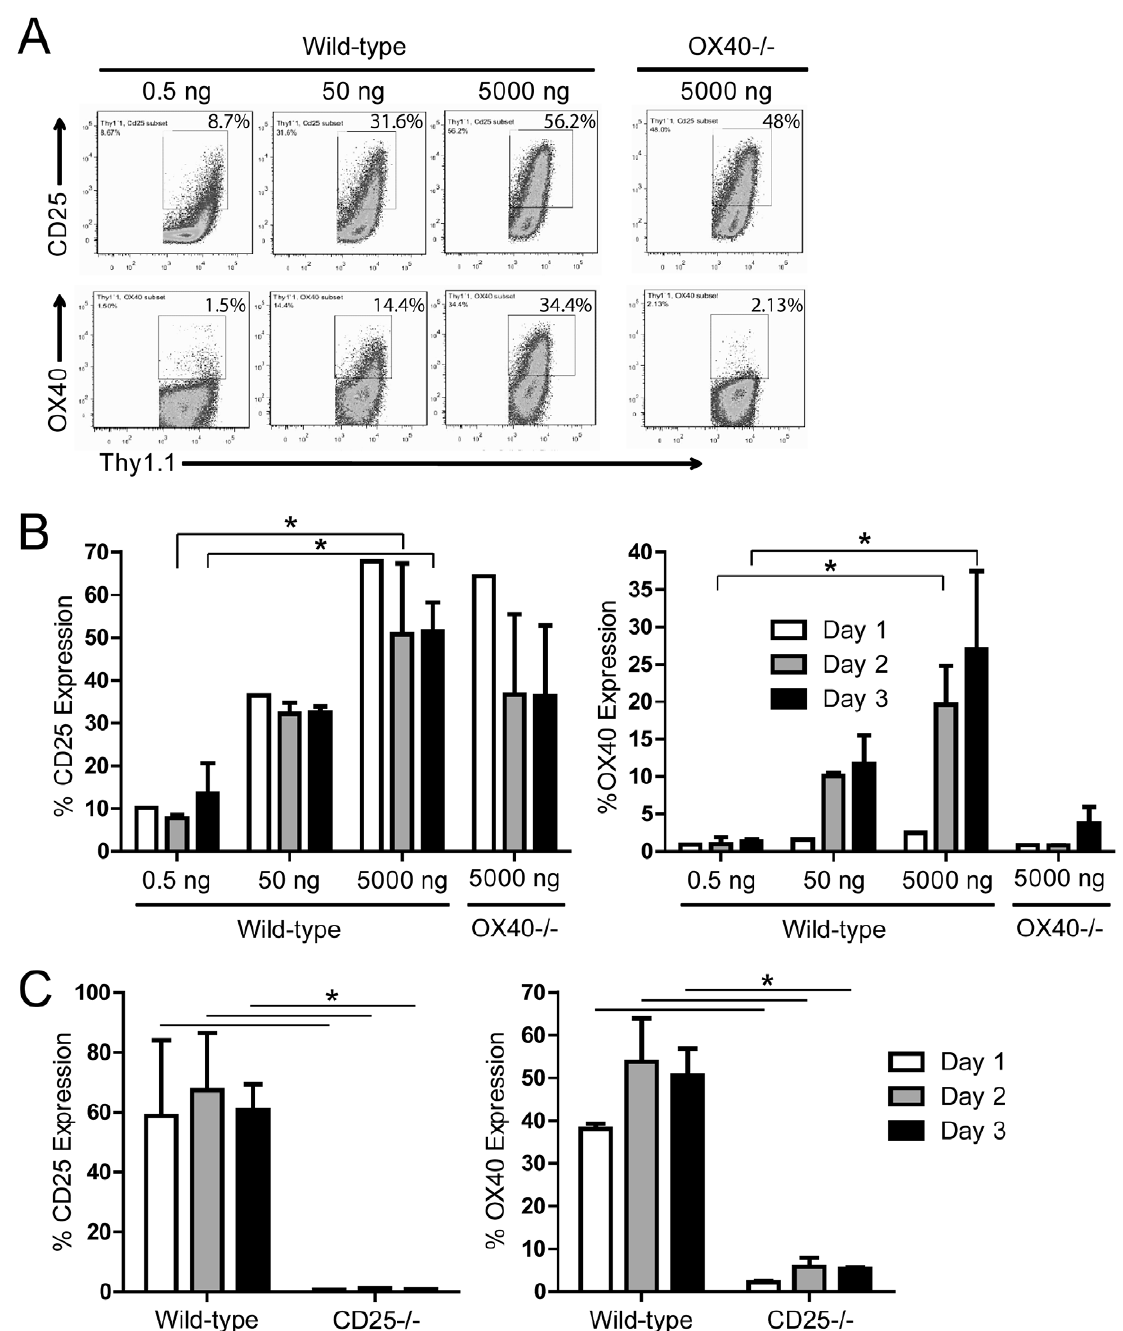
Figure 1. OX40 is regulated by TCR stimulation and IL-2Ralpha (CD25) expression. ( A, B ) Naı¨ve wild-type or OX40 2 / 2 OT-I T cells (2 6 10 5 / ml) were stimulated with peptide-pulsed APCs (2 6 10 3 /ml). A ) Three days later, OT-I T cells were harvested and the extent of CD25 and OX40 expression were determined. B ) Kinetics of CD25 and OX40 expression following TCR stimulation were determined at the indicated time points by flow cytometry. ( C ) Naı¨ve polyclonal wild-type or CD25 2 / 2 CD8 T cells (3 6 10 5 /well) were CFSE-labeled and then stimulated with anti-CD3 and anti- CD28 (1 and 5 mcg/ml, respectively). One to three days later, CD8 T cells were harvested and the extent of CD25 and OX40 expression were determined. B, C ) Bar graphs depict the mean + / 2 SD (n=2–3/group). Data are representative of one out of two to three independent experiments. *P , 0.05. doi:10.1371/journal.pone.0034467.g001 molecules. Next, we examined whether TCR stimulation plus was determined. Stimulation with exogenous rIL-2 led to a statistically significant increase in both CD25 and OX40 exogenous rIL-2 similarly regulated OX40 expression on human expression compared to media alone (Fig. 2A), demonstrating T cells. Freshly isolated purified human CD8 or CD4 T cells were that IL-2 signaling was sufficient to drive up-regulation of these stimulated with anti-CD3 + / 2 rhIL-2 and the expression of CD25